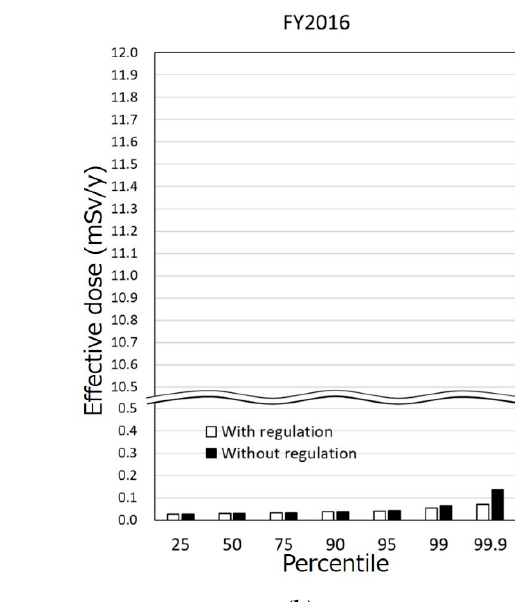
Figure 3. Radiation exposure doses in FY2012 ( a ) and FY2016 ( b ) throughout Japan estimated using 267,717 and 296,708 samples, respectively. Results of unnamed samples and processed foods whose main foodstuffs could not be identified were eliminated from the random sampling.